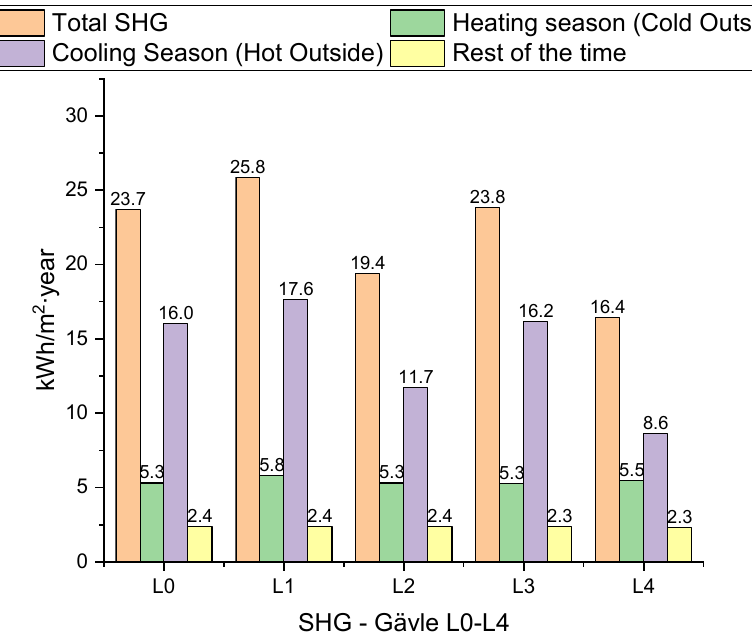
Figure 17. SHGs for Gävle under effect of L parameters including LEF windows. The same reduction of SHGs with respect to the locations can be seen in Figure 18, except for a 32% reduction for Beirut and Jakarta during the hot season. L1– L4 replicated the same pattern as B, but at a lower level of SHG. In other parts of the world, outside Sweden, the results indicated the same reduction pattern in the range of a 32–37% reduction of SHG.